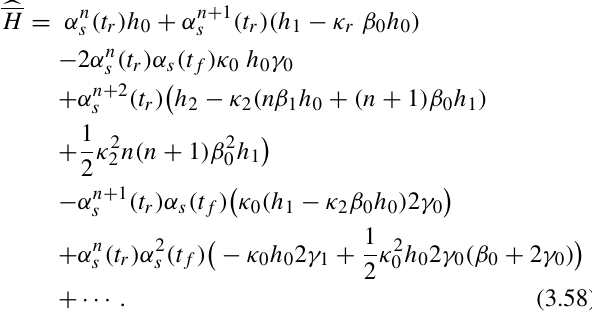
erature: see e.g. Ref. [26], Eq. (2.17). Therefore, varying